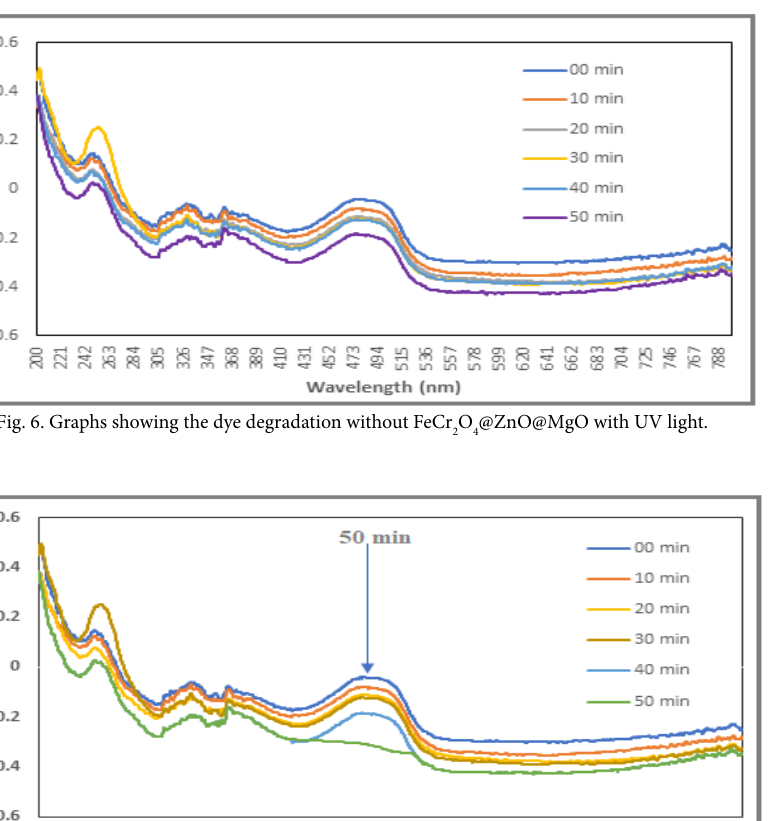
Fig. 7. Graphs showing the dye degradation in presence of FeCr